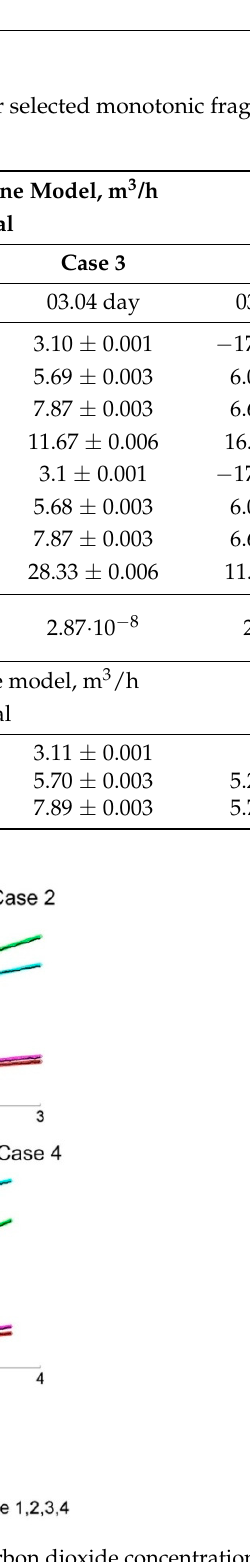
Figure 7. Fitting of the estimated and calculated curves of carbon dioxide concentration in apartment I for cases from.